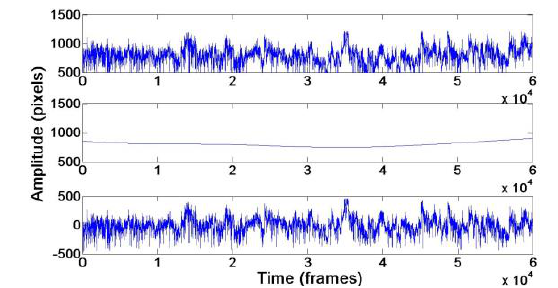
Fig. 2. The raw pupil area signal (top) and its reconstruction using the wavelet coefficients (middle). We obtain a detrended signal (bottom) by subtracting the wavelet approximation from the original signal. The sampling rate is 25 frames/second.